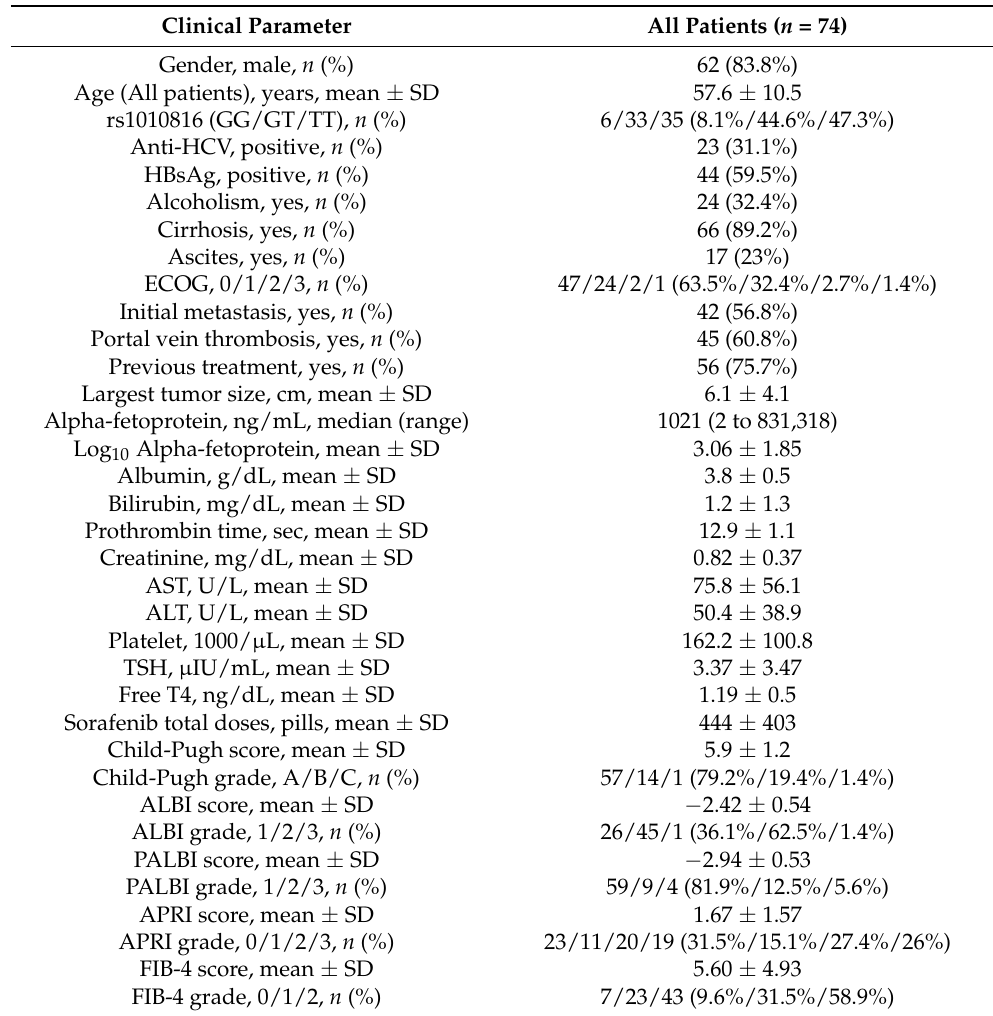
Table 1. Clinical characteristics of patients